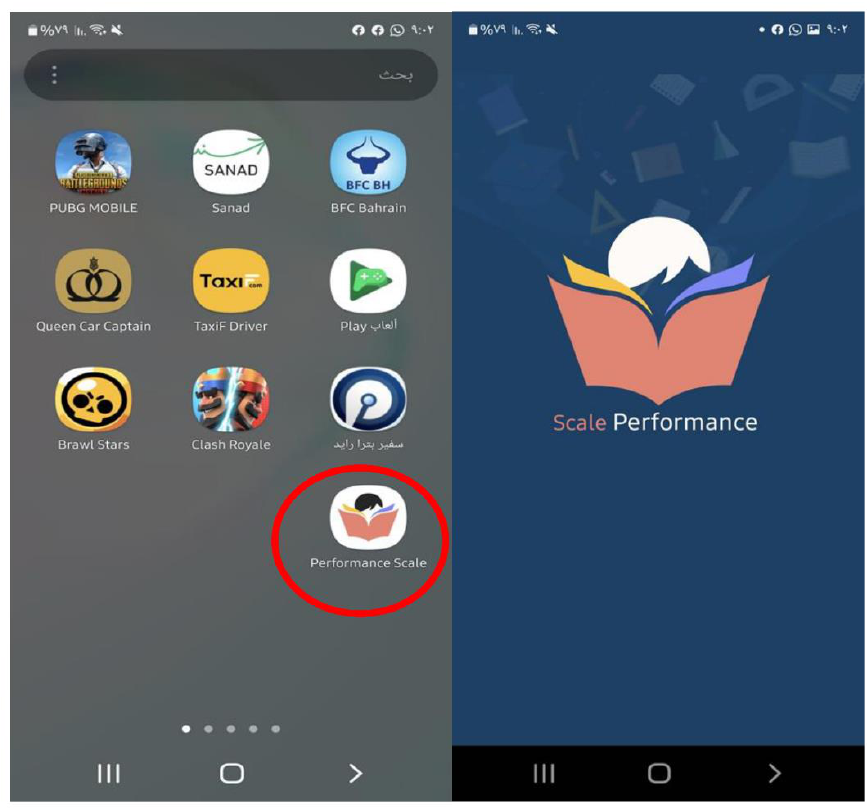
Figure 1. The Scale Performance